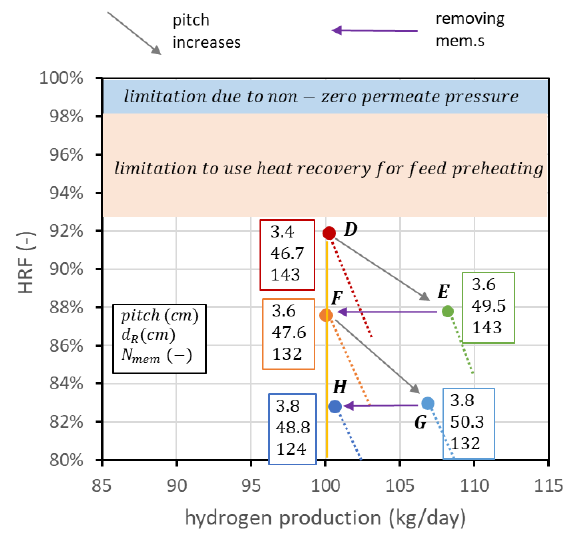
Figure 14. Creation of a set of points (D, F, H) that matches the target production of hydrogen for different combinations of 𝐻𝑅𝐹 and number of membranes.